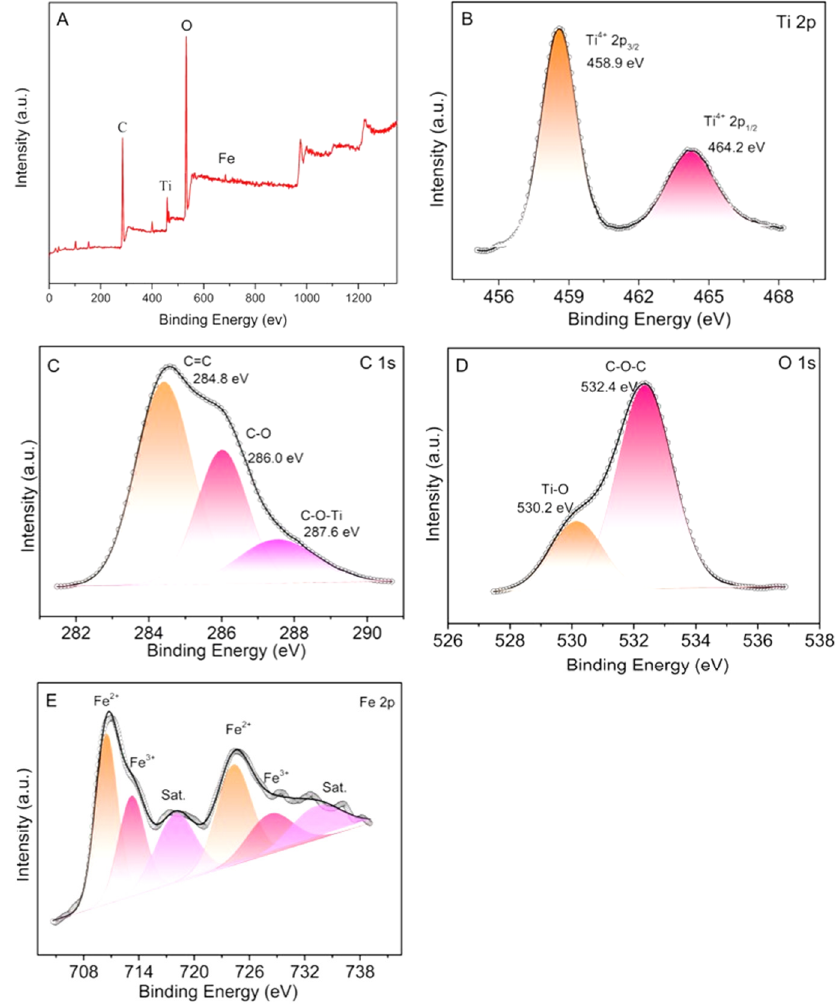
Figure 5. XPS spectra of the TiO 2 -RH composite: ( A ) Survey spectrum, ( B ) Ti 2p, ( C ) C 1s, ( D ) O 1s, and ( E ) Fe 2p.